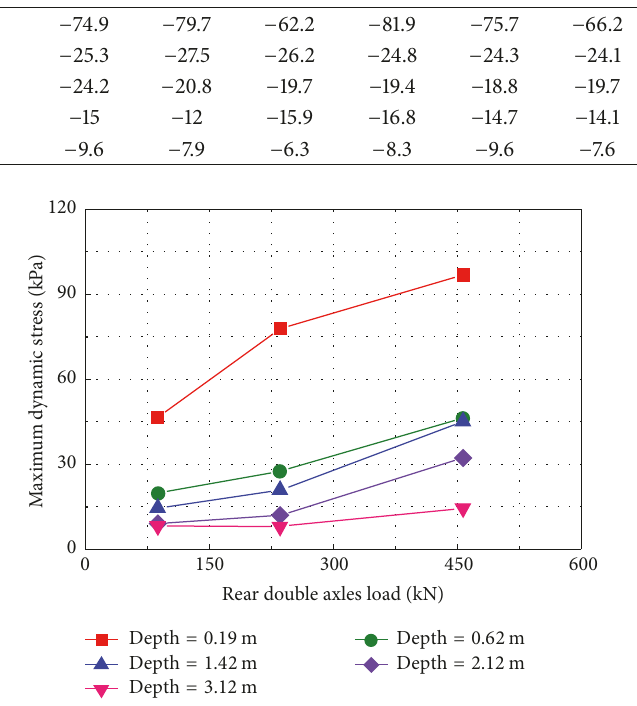
Figure 9: Relationship between rear double axles load and maximum dynamic